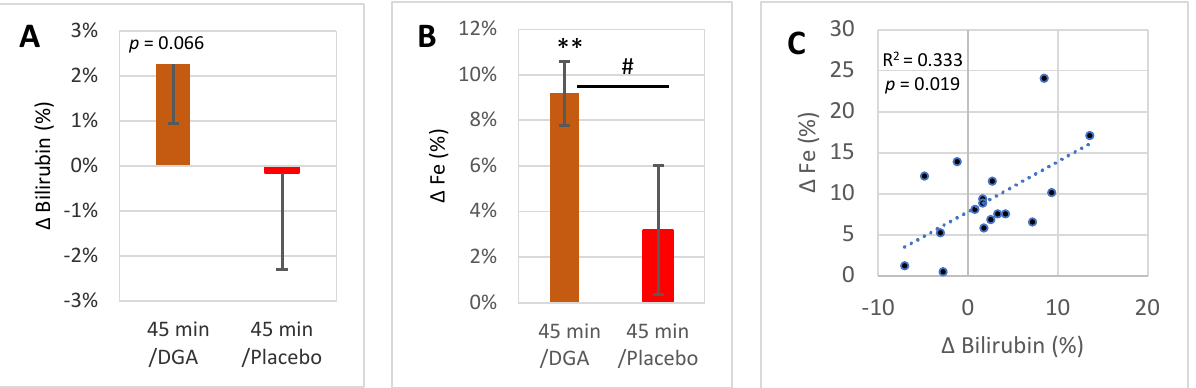
Figure 3. HO-1 pathway end products excluding CO in blood 45 min after acute DGA dose: ( A ) 45 min average intraindividual percent change in bilirubin (±SEM), ( B ) similar 45 min change in Fe (±SEM), ( C ) scatter diagram between 45 min %-changes of bilirubin and Fe after acute DGA dose. Notes: * and ** indicate paired t -test, # indicates non-paired t -test between the %-changes in 45 min. In ( C ), the p -value is based on an F-test.